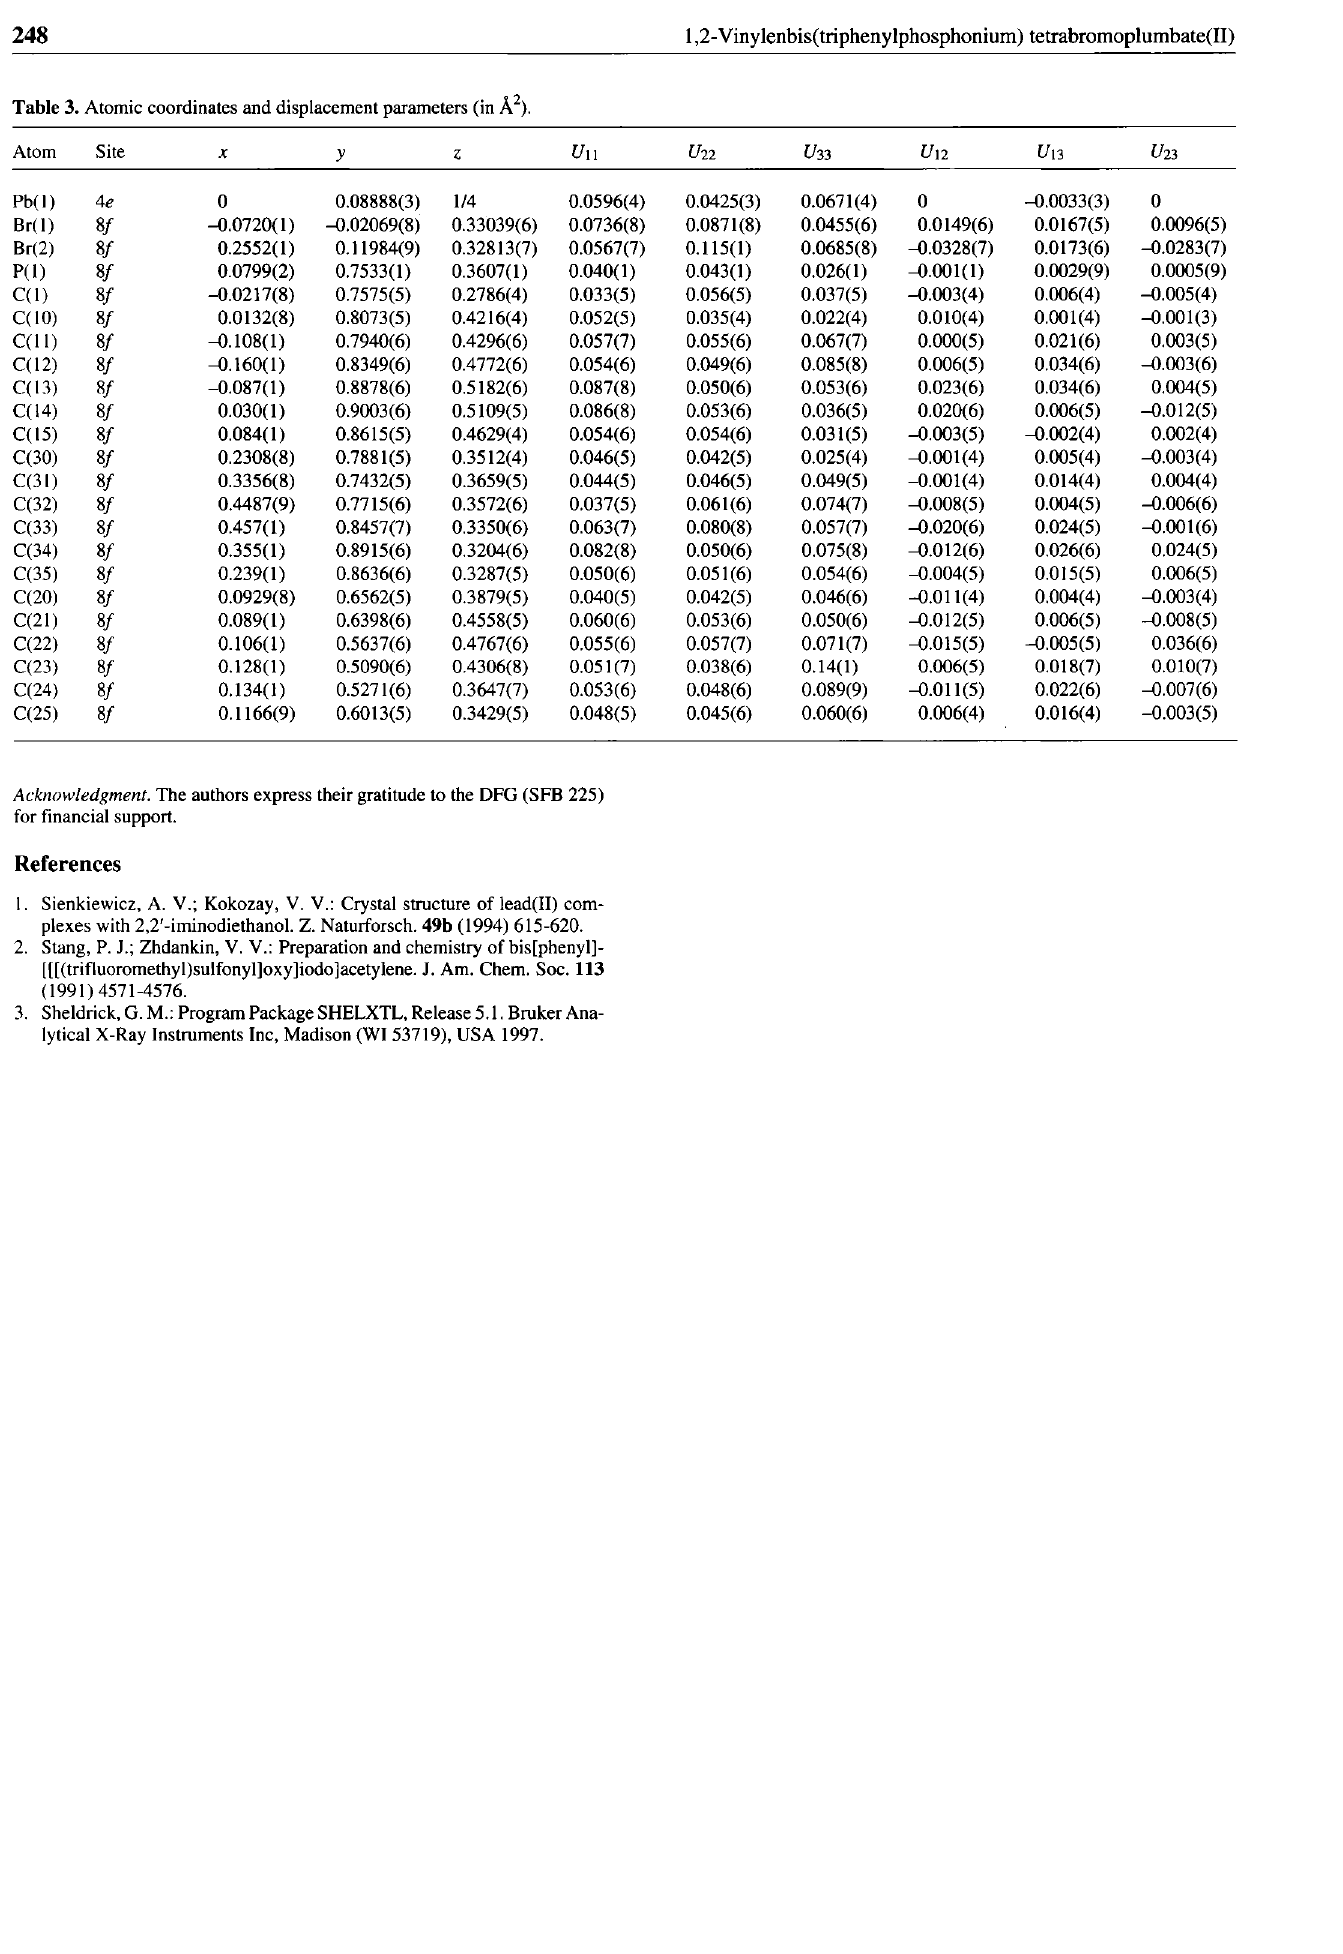
Table 3. Atomic coordinates and displacement parameters (in Ä 2